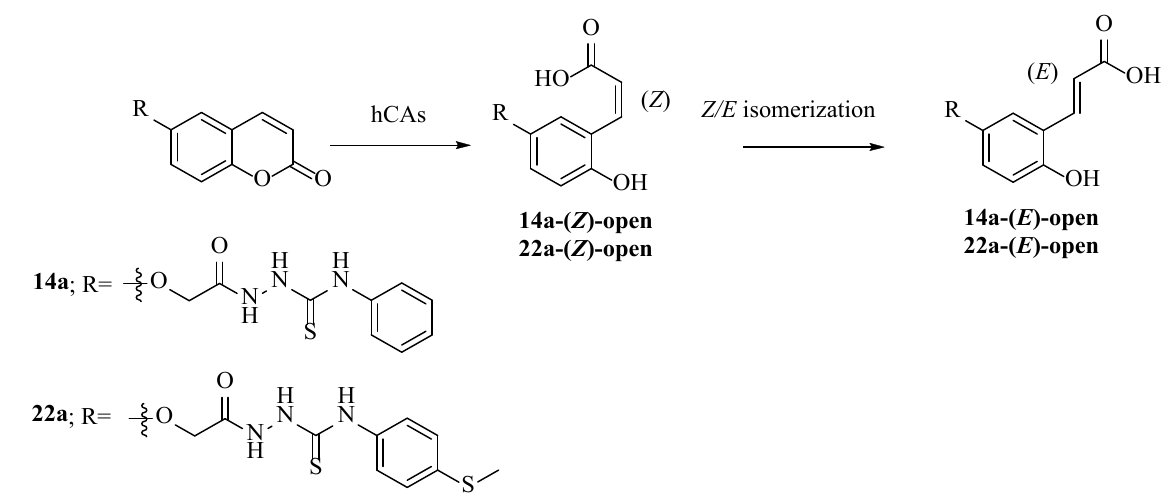
Figure 1. Hydrolysis of the coumarin scaffolds and Z / E geometrical isomerization.